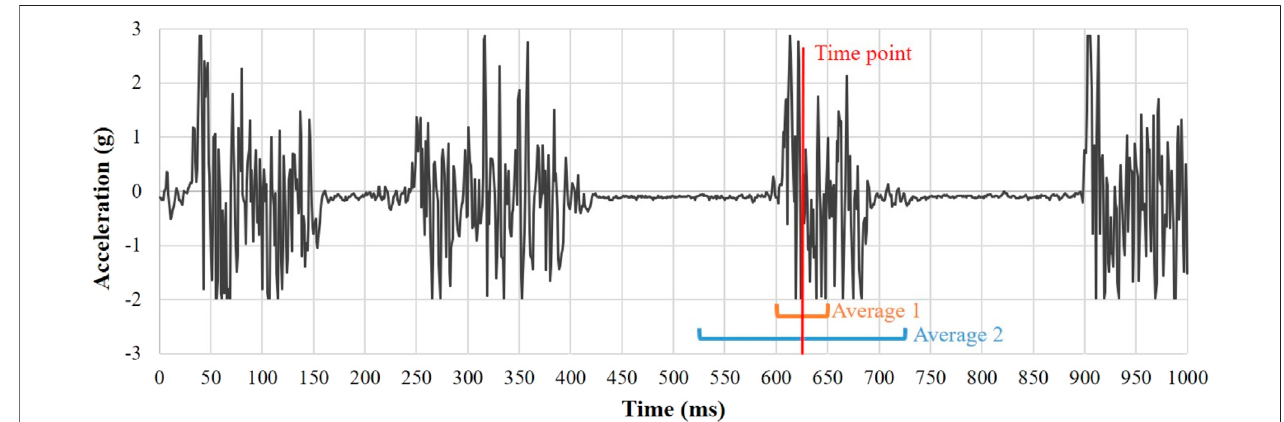
FIGURE11| Accelerationpro fi lewhere thestick-slip phenomenonoccurs.Atacertain timepoint, iftheaverageamplitudewithin50 ms(Average1)isgreaterthan twice the average amplitude within 200 ms (Average 2), it is considered that stick-slip phenomenon